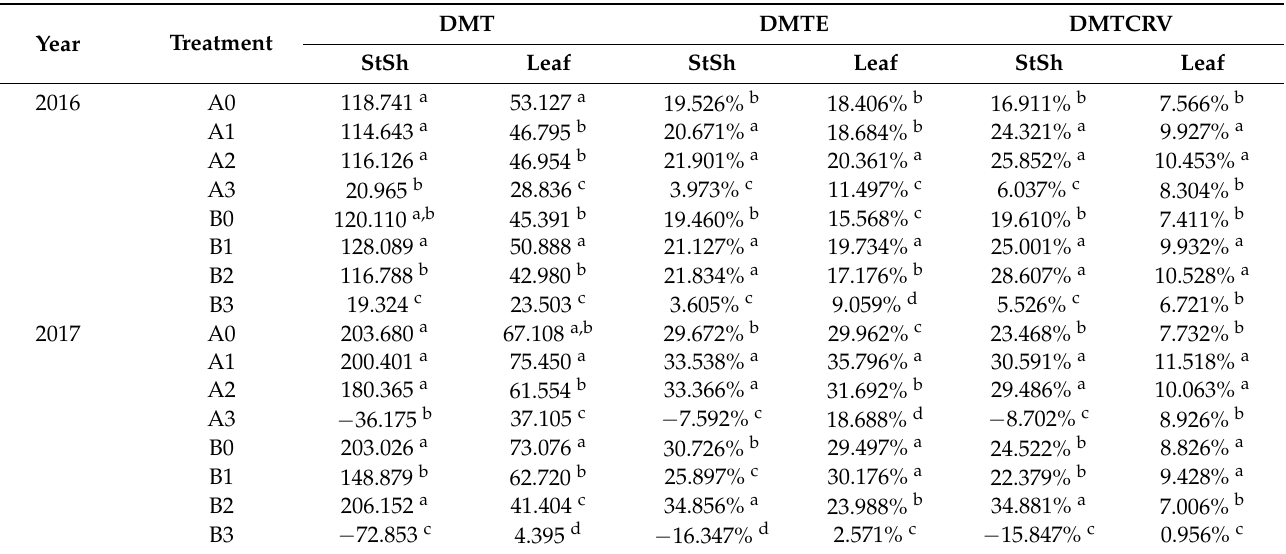
Values for the same organ and the same varieties followed by different letters are significantly different at p = 0.05. DMT-dry matter translocation; DMTE-dry matter translocation efficiency; DMTCRV-dry matter translocation conversion rate of the vegetative organ. StSh, stem and sheath. A0 and B0, control treatments (0 kPa) of SJ6 and DN425; A1 and B1, mild drought stress treatments ( − 10 kPa); A2 and B2, mild drought stress